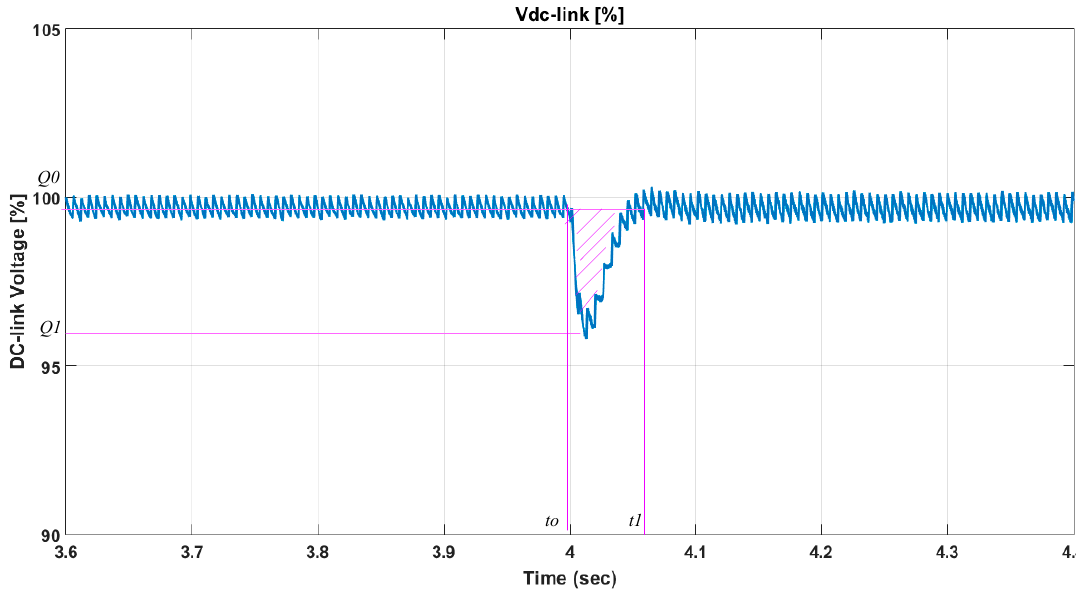
Figure 24. Dc-link voltage for calculating the resilience.